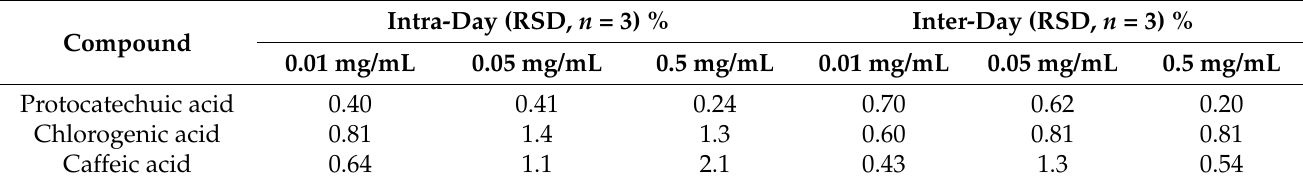
Table 2. Intra-day and inter-day precision and accuracy